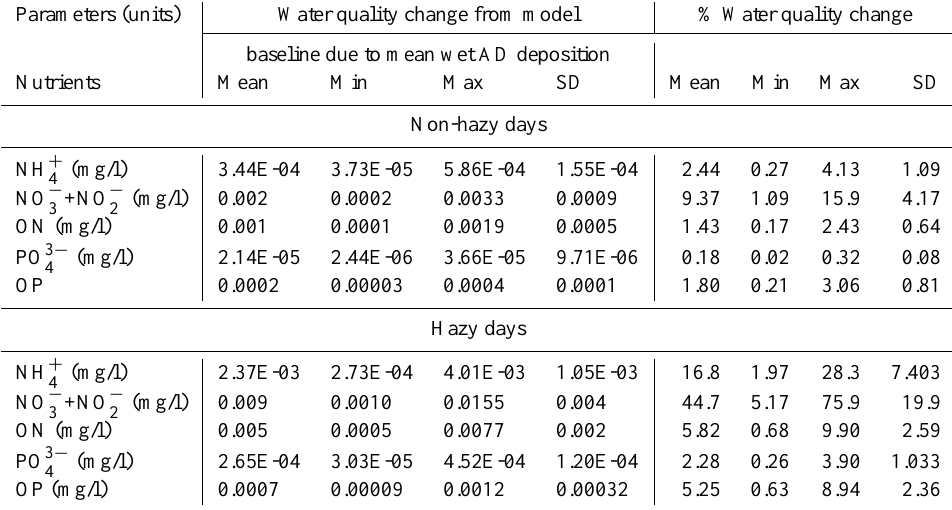
Table 4. Model computed concentration of N and P species at water surface due to atmospheric deposition fluxes during non-hazy and hazy